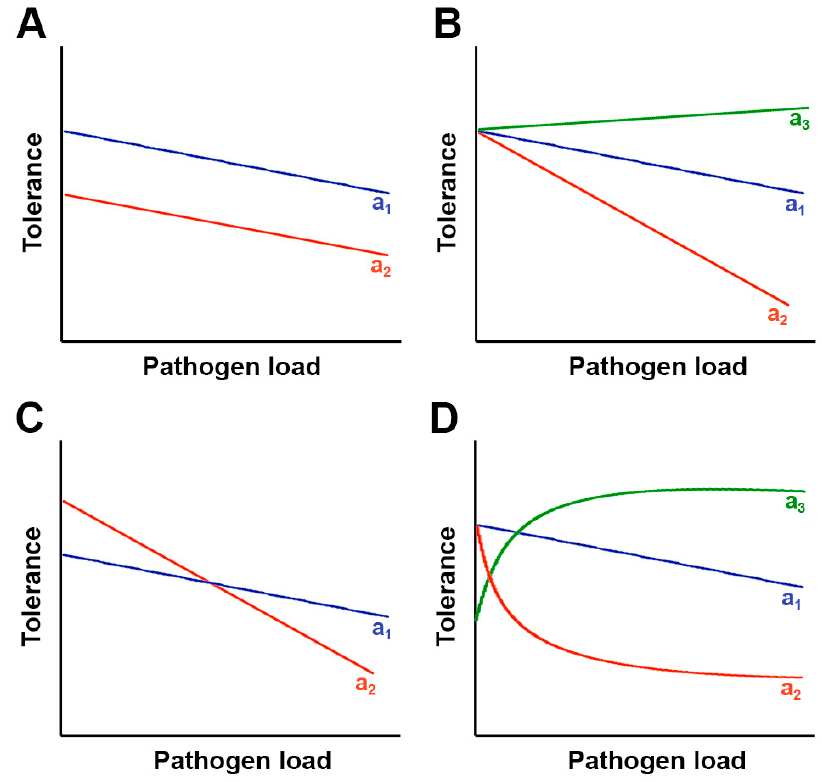
Figure 1. Range versus point tolerance. Depending on the scenario, range tolerance and point tolerance do not necessarily lead to the same conclusion. ( A ) Host genotype a 1 (blue) has higher fitness than genotype a 2 (red) when uninfected and at every pathogen load, but range tolerance is the same in both genotypes. Point tolerance will always indicate higher tolerance of genotype a 1 ; ( B ) Host genotype a 1 and a 2 have the same fitness when uninfected, but range tolerance is higher in a 1 than in a 2 . Point tolerance will agree with range tolerance at every pathogen load. Genotype a 3 (green) overcompensates detrimental effects of infection at every pathogen load (positive slope of the reaction norm); ( C ) Host genotype a 1 has lower fitness than genotype a 2 when uninfected, but range tolerance is higher for genotype a 1 than for a 2 . Point tolerance will agree with range tolerance at higher, but not at lower, pathogen load; ( D ) Both genotypes have the same fitness when uninfected. Range tolerance is linear for genotype a 1 but not for genotype a 2 . Genotype a 2 has lower range tolerance than a 1 in the exponential part, but higher in the plateau, of the reaction norm. Point tolerance will always be higher for genotypes a 1 . Genotype a 3 overcompensates the detrimental effect of pathogen infection up to a maximum.